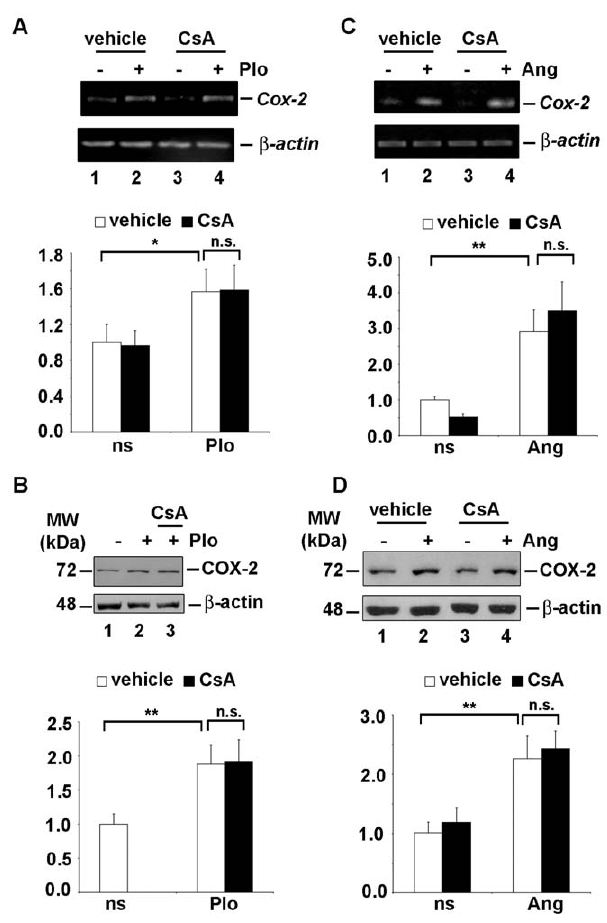
Figure 6. Calcium-induced COX-2 expression was not abrogat- ed by CN inhibition in primary ESC from early pregnant rats. ESC were isolated from uteri of pregnant rats on 4.5 day post coitus (d.p.c). (A and C) The Cox-2 mRNA was amplified from total RNA purified from primary cultures of the isolated cells by semi-quantitative RT-PCR. The transcript of b -actin was used as internal control. Cells were pretreated for 1 h with vehicle (lanes 1 and 2) or 200 ng/ml of CsA (lanes 3 and 4), and then exposed for 4 h to PIo (A), 500 nM of Ang II (C) (lanes 2 and 4) or left unstimulated (lanes 1 and 3). (B and D) Immunoblots showing endogenous protein expression of COX-2 and b - actin as a loading control. (B) Primary cultures of the isolated cells were pretreated for 1 h as before with vehicle (lanes 1 and 2) or CsA (lane 3), and then exposed to PIo for 8 h (lanes 2 and 3) or not (lane1). (D) Primary cultures of the isolated cells were pretreated for 1 h with vehicle (lanes 1 and 2) or CsA (lane 3 and 4), and then exposed to Ang II for 8 h (lanes 2 and 4) or not (lanes1 and 3). (A–D) Lower panels bar graphs show the densitometric data analysis of the results shown in upper panels. The COX-2/ b -actin ratio was calculated and plotted against the values obtained with the control, vehicle-treated non- stimulated rat ESC (ns), which were assigned a value of 1. Open bars, cells pre-treated with vehicle; closed black bars, cells pre-treated with CsA. Values plotted are the means 6 SD of the fold induction values obtained from three independent experiments. *P , 0.05; ** P , 0.01